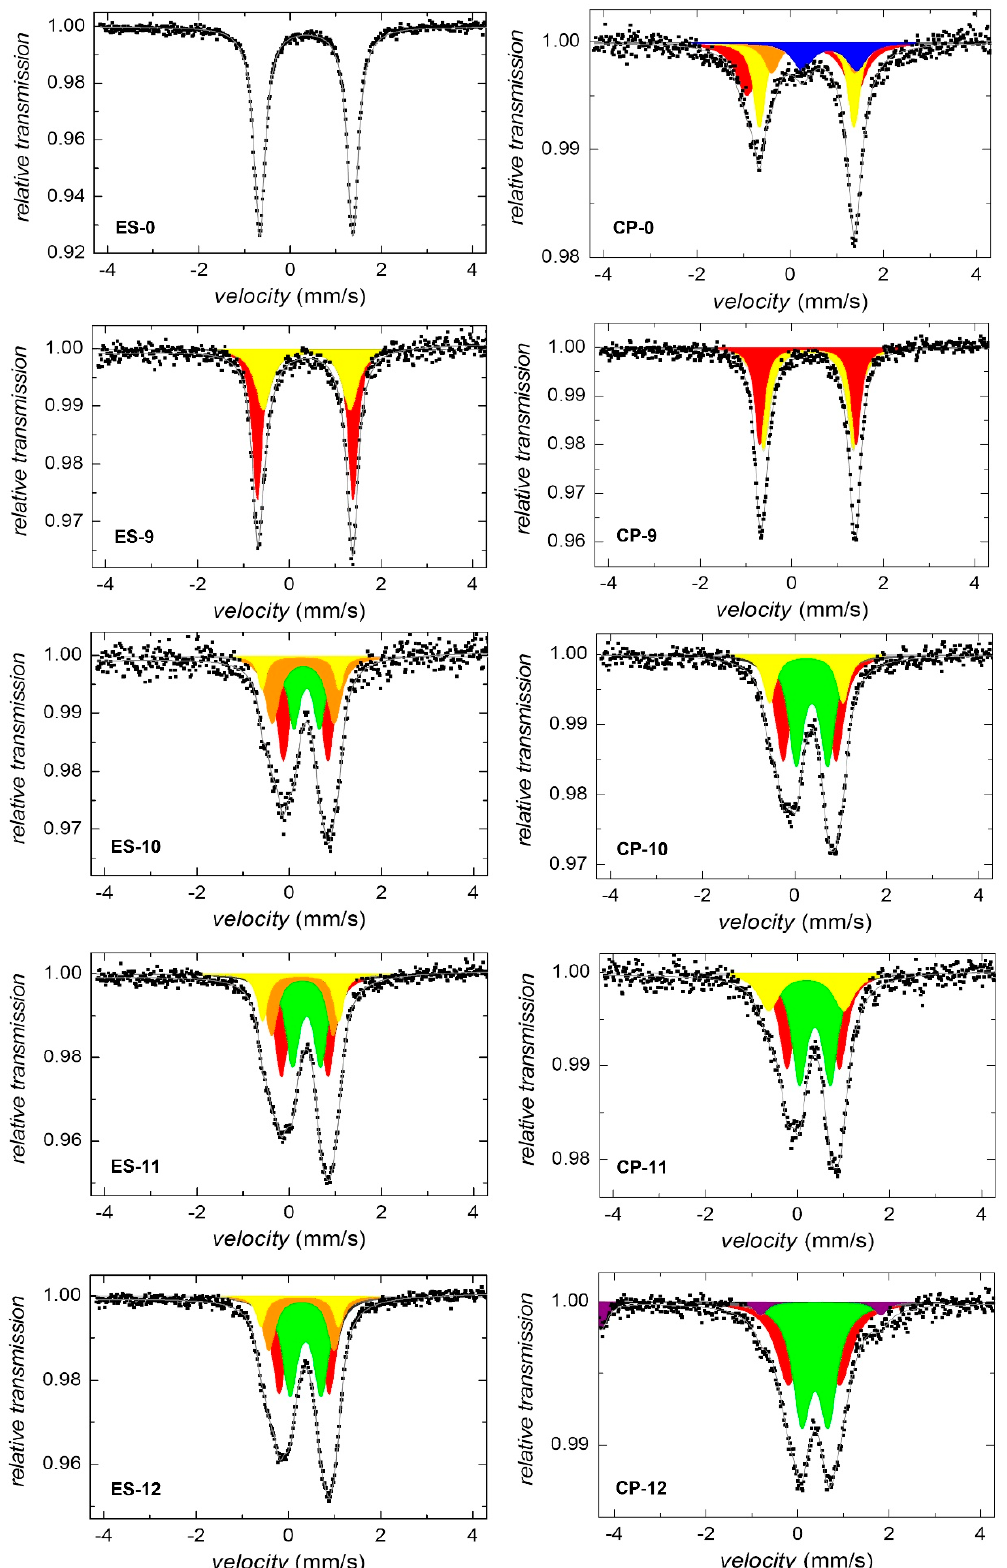
Figure 8. Room-temperature Mössbauer spectra of the ES and CP samples in their original state (ES-0, CP-0) and after annealing from 900 to 1200 °C. Experimental points are plotted as solid symbols. Fitting curves for all data points are gray. Decomposed peaks are also colored with different shades of gray. Shaded sub-spectra correspond in color to Fe 3+ sites from Tables 7 and 8.